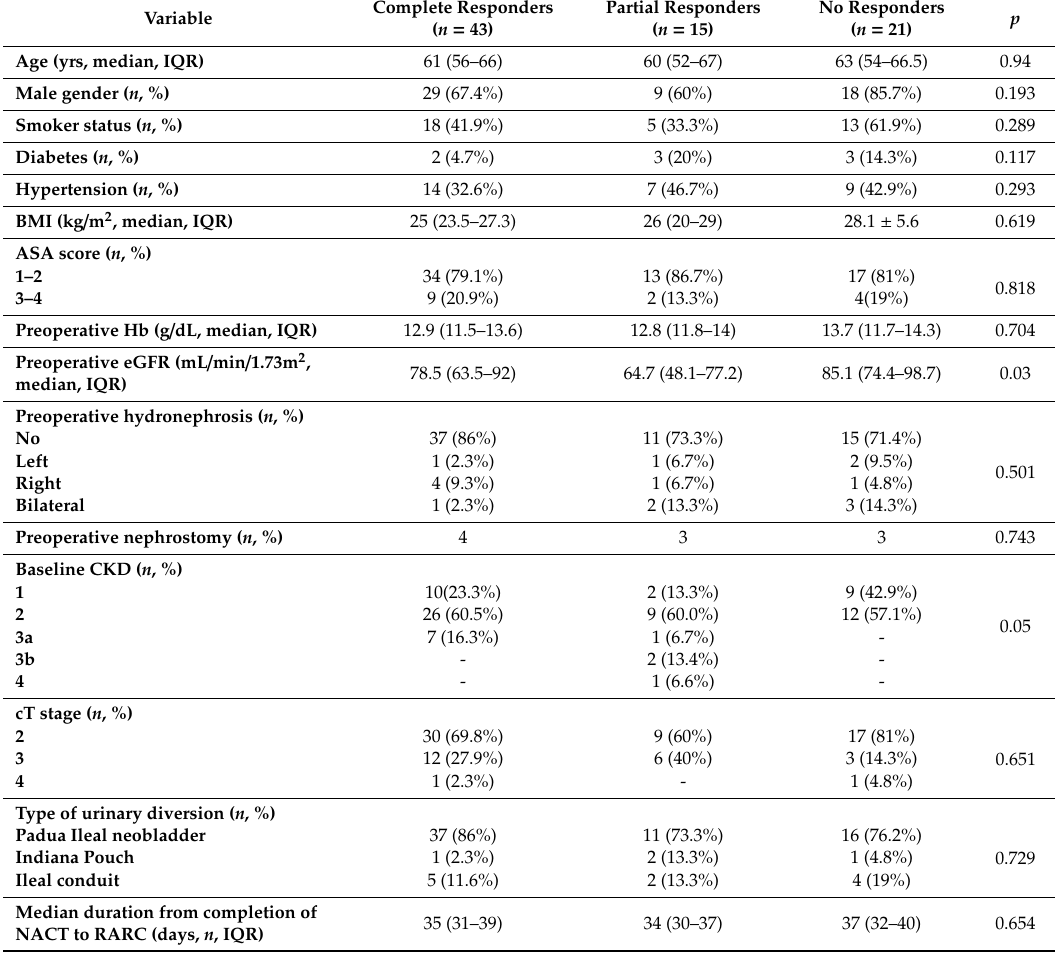
Table 1. Patient demographic, clinical, and preoperative data according to NACT response